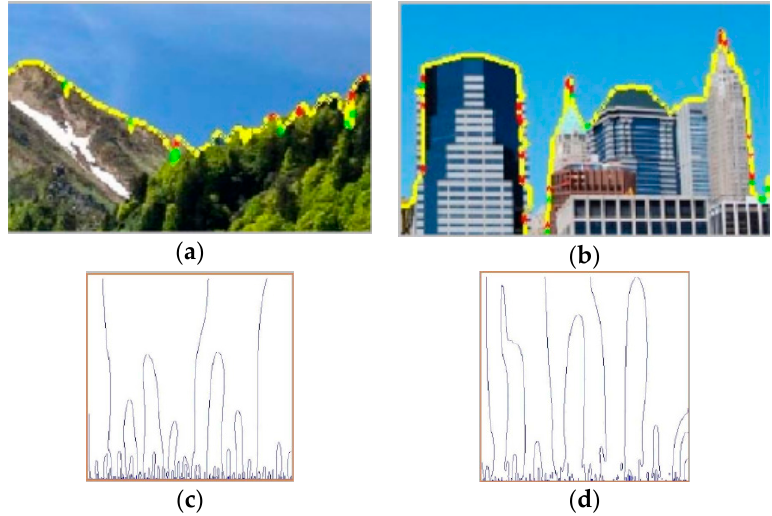
Figure 2. Representing the skylines in ( a , b ) by their respective Curve Scale Space (CSS) in ( c , d ).